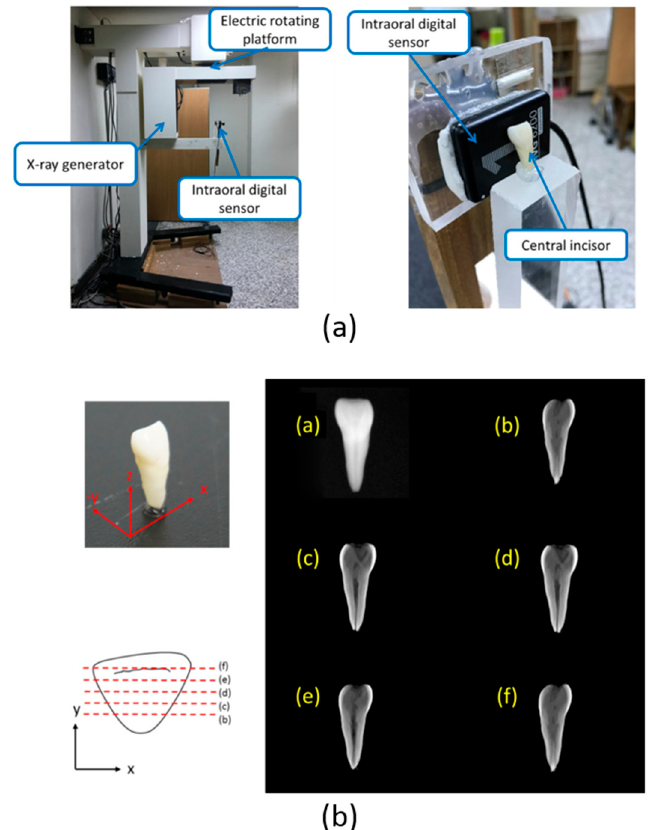
Figure 1. The 2.5D Periapical Radiography System was developed in 2018 [8]. ( a ) Prototype of the intraoral digital tomosynthesis system. ( b ) Reconstructed images obtained from the 2.5D prototype of the intraoral digital tomosynthesis system at di ff erent distances from the sensor surface.